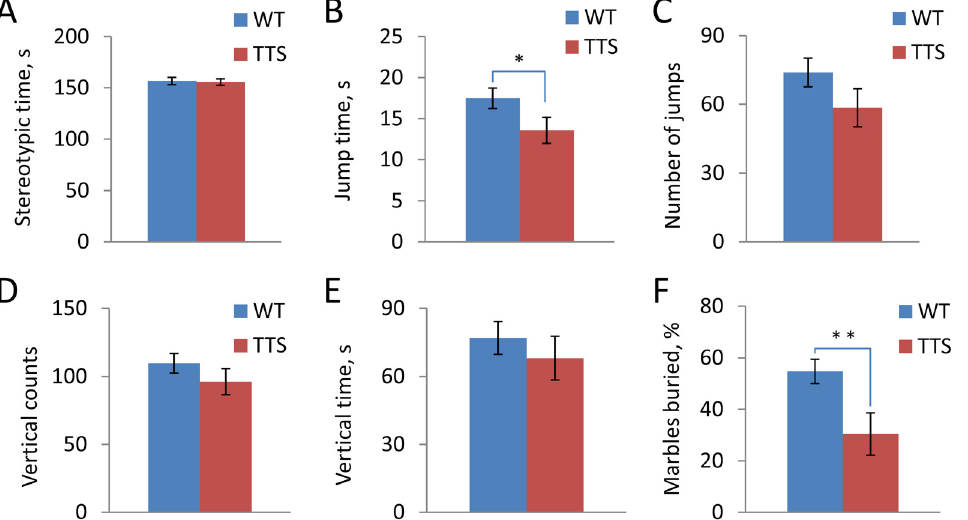
Fig 3. Stereotypic and repetitive behaviors. A: Time spent on stereotypic movements; B: Jumping time; C: The number of jumps; D: Vertical counts; E: Vertical time; F: Percentage of buried glass marbles. Mean ± SEM. Number of tested animals WT = 22; TTS = 12. * p < 0.05 and ** p < 0.01, significantly different from WT